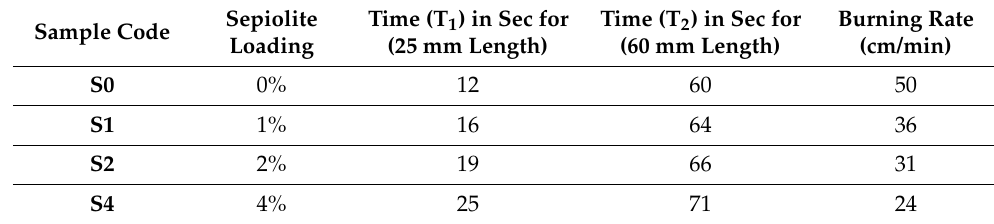
Figure 9. ( a ) Lighting of composite sample, ( b ) Distance of 25 mm traveled by the flame in T1, ( c ) Distance of 60 mm traveled by the flame in T2. Table 4. Flame retardancy test